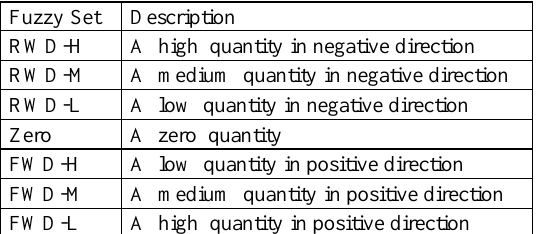
Table 5 Explanation of Fuzzy